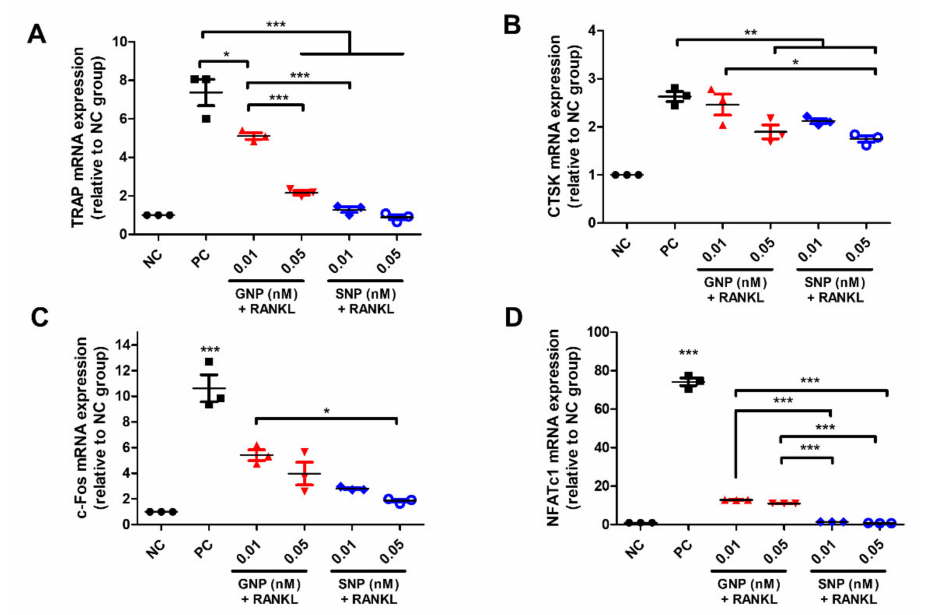
Figure 5. The mRNA expression level of ( A ) TRAP, ( B ) Cathepsin K (CTSK), ( C ) c-Fos, and ( D ) Nu- clear activated T-cells, cytoplasmic 1 (NFATc1), with various concentrations of GNPs or SNPs. BMMs were differentiated into osteoclasts with CCM for five days. BMMs of the negative control (NC) group were cultured with CM. RANKL-induced BMMs of the positive control group (PC) were cultured with CCM. The mRNA expression levels at various concentrations of GNPs or SNPs were measured. The results are expressed as the mean ± SD ( n = 3 per group). “*” indicates a significant difference for which p < 0.05. “**” indicates a significant difference for which p < 0.01. “***” indicates a significant difference for which p < 0.001.